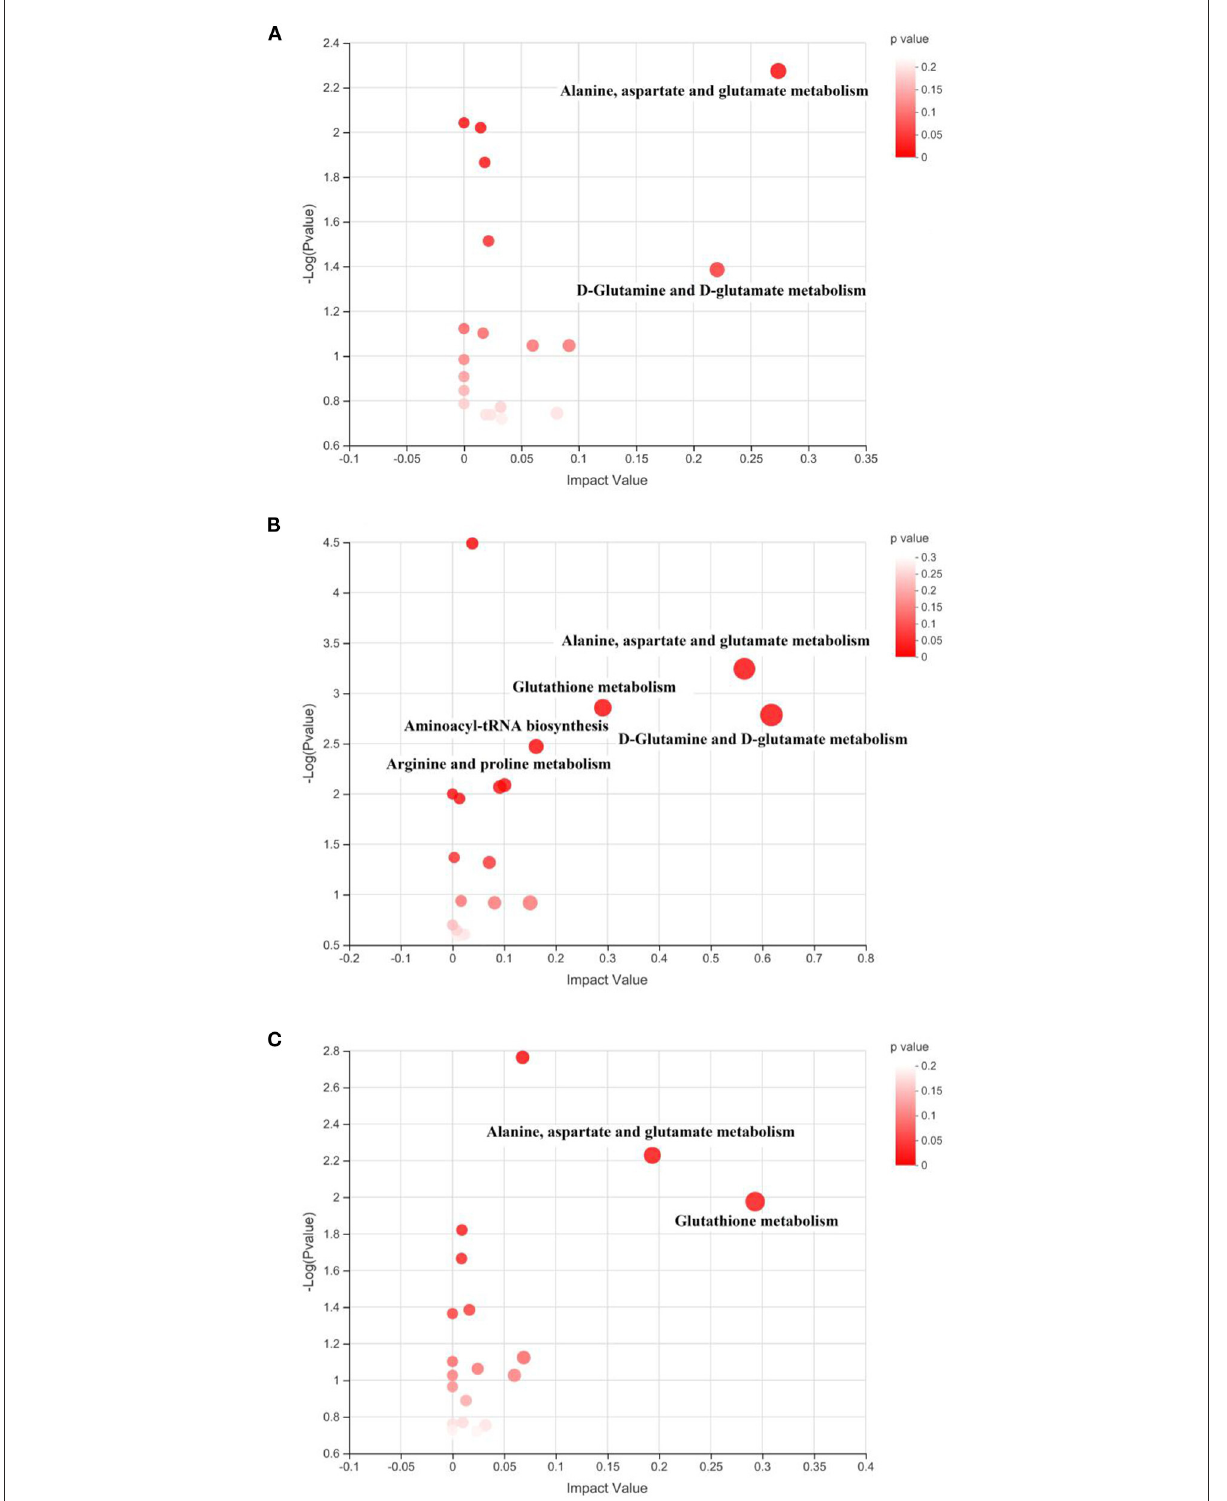
FIGURE9 Topological analysis of the metabolic pathways. (A) Ex vs. HFD; (B) FA vs. HFD; (C) Ex-FA vs. HFD. HFD, high-fat diet group (model); Ex, high-fat diet with exercise; FA, high-fat diet with ferulic acid; Ex-FA, high-fat diet with exercise and ferulic acid.